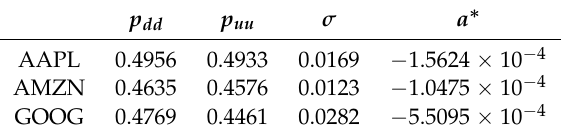
Table 6. Above, we have the values for a ∗ , σ , as well as the probabilities of an upwards/downwards movement, given an upwards/downwards movement for the three stocks of interest.